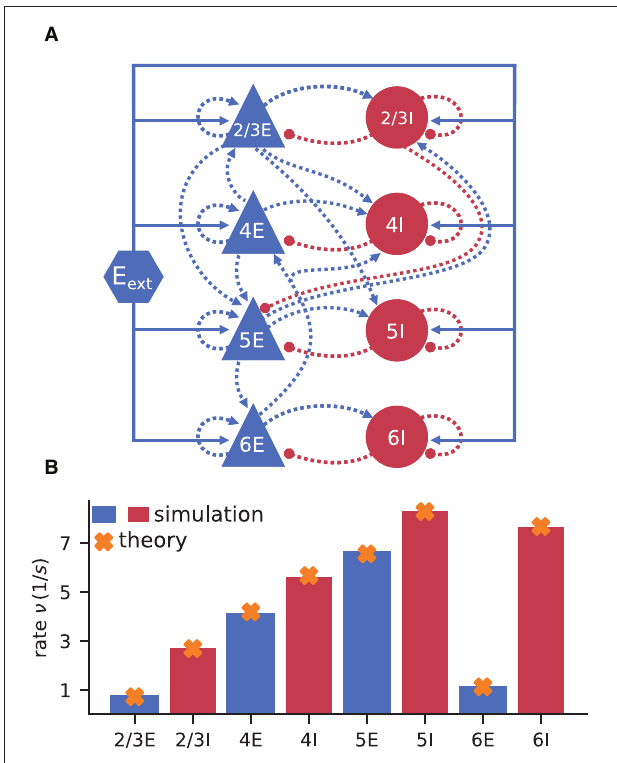
FIGURE 3 | Cortical microcircuit model by Potjans and Diesmann (2014). (A) Network diagram (only the strongest connections are shown as in Figure 1 of the original publication). Same notation as in Figure 2A . (B) Simulation and mean-field estimate for average population firing rates using the parameters from Bos et al.